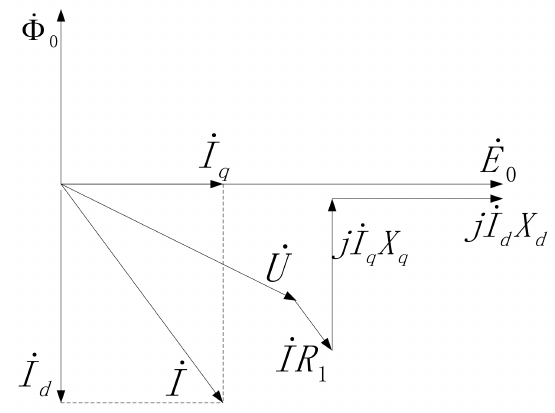
Figure 6. Vector diagram of the TPMLG.